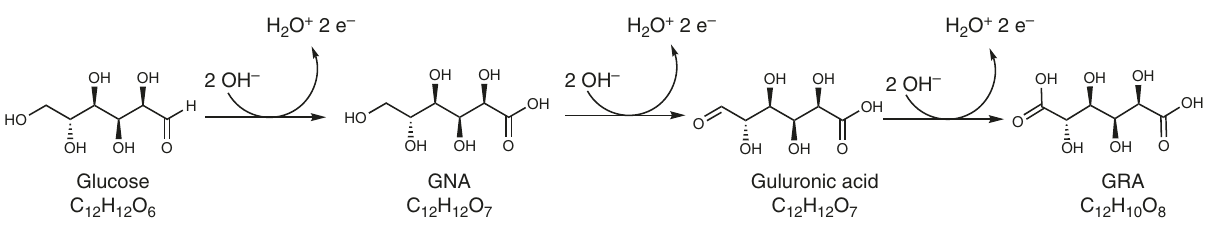
Fig. 3 Possible reaction pathway from glucose to GRA. Schematic illustration of the possible pathway for the electrochemical oxidation of glucose to GNA and